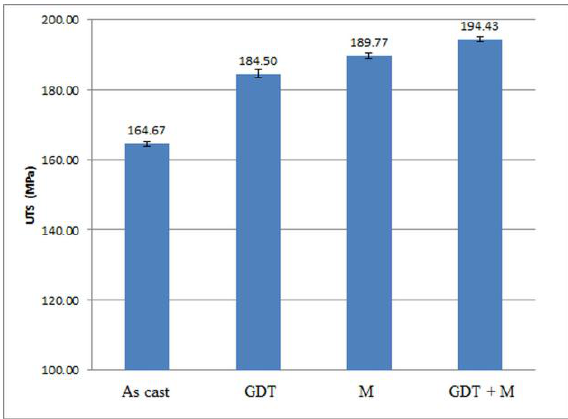
Figure 7. Results of ultimate tensile strength (UTS) measurements performed on A356